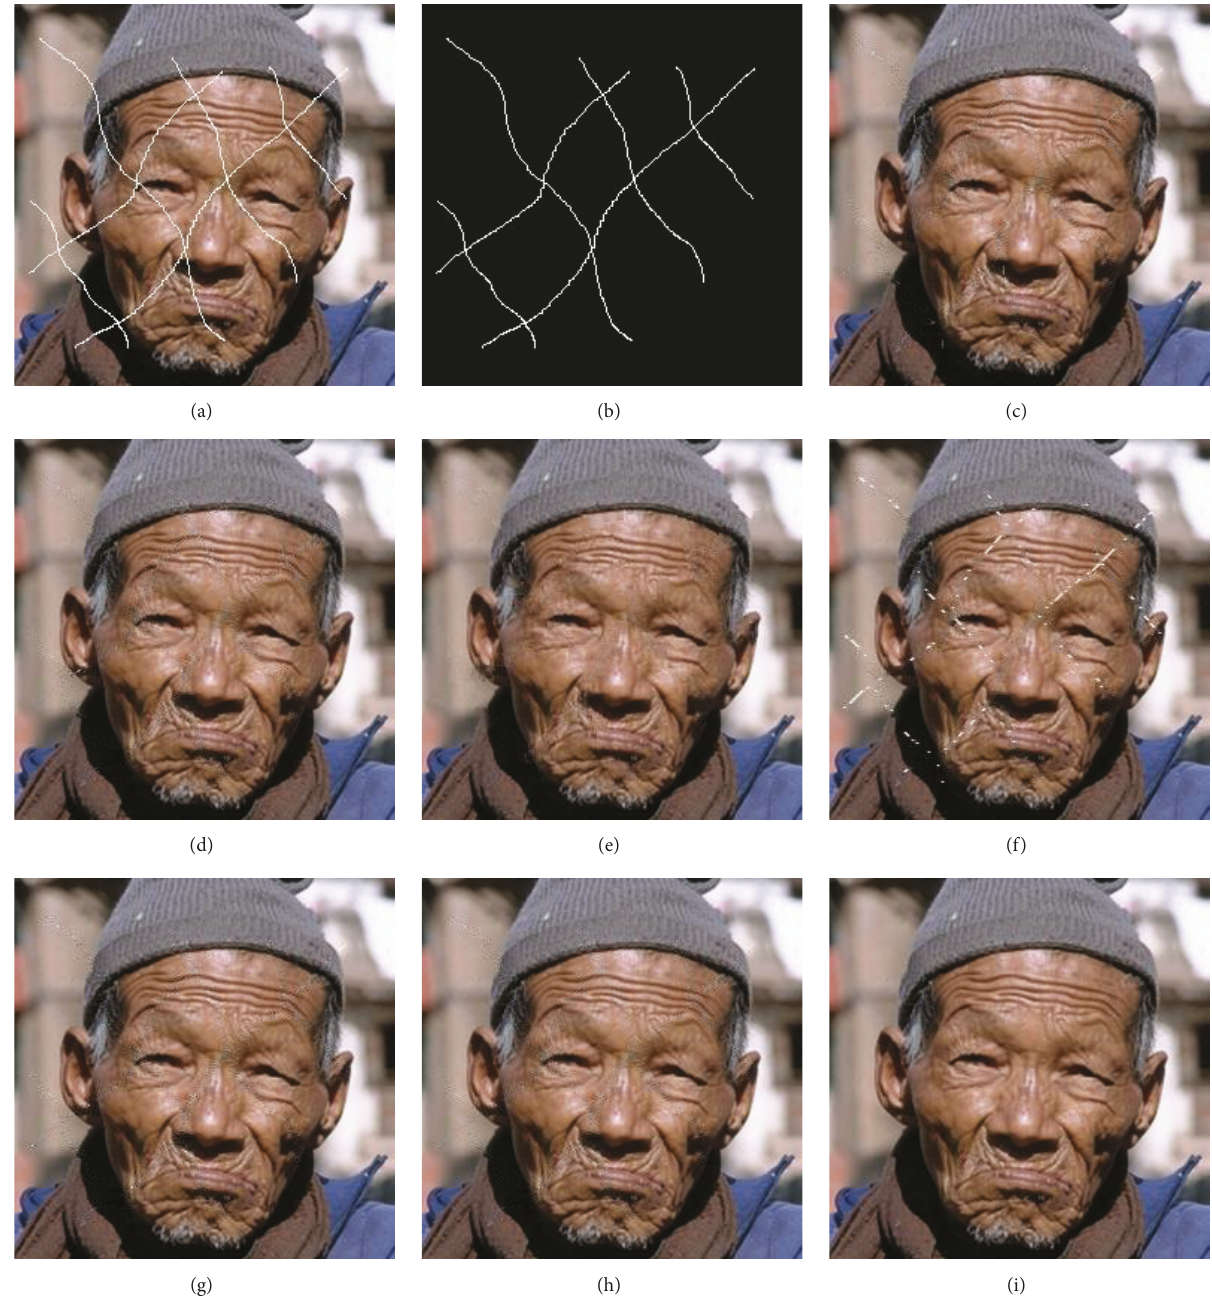
Figure 7: Repaired results by different inpainting methods. (a) The damaged image; (b) the mask image; (c) by BSCB; (d) by CT; (e) by EB; (f) by TV; (g) by Thiele; (h) by our method; (i) the original